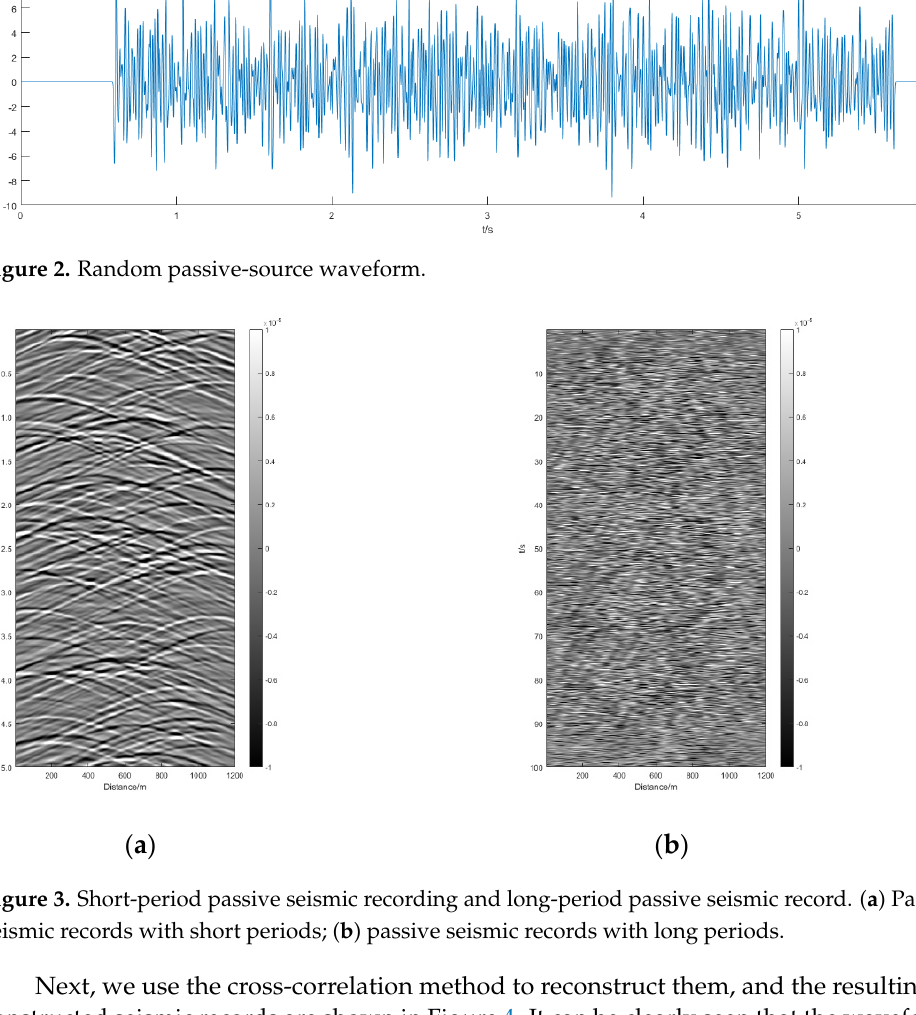
Figure 3. Short ‐ period passive seismic recording and long ‐ period passive seismic record. ( a ) Passive seismic records with short periods; ( b ) passive seismic records with long periods.